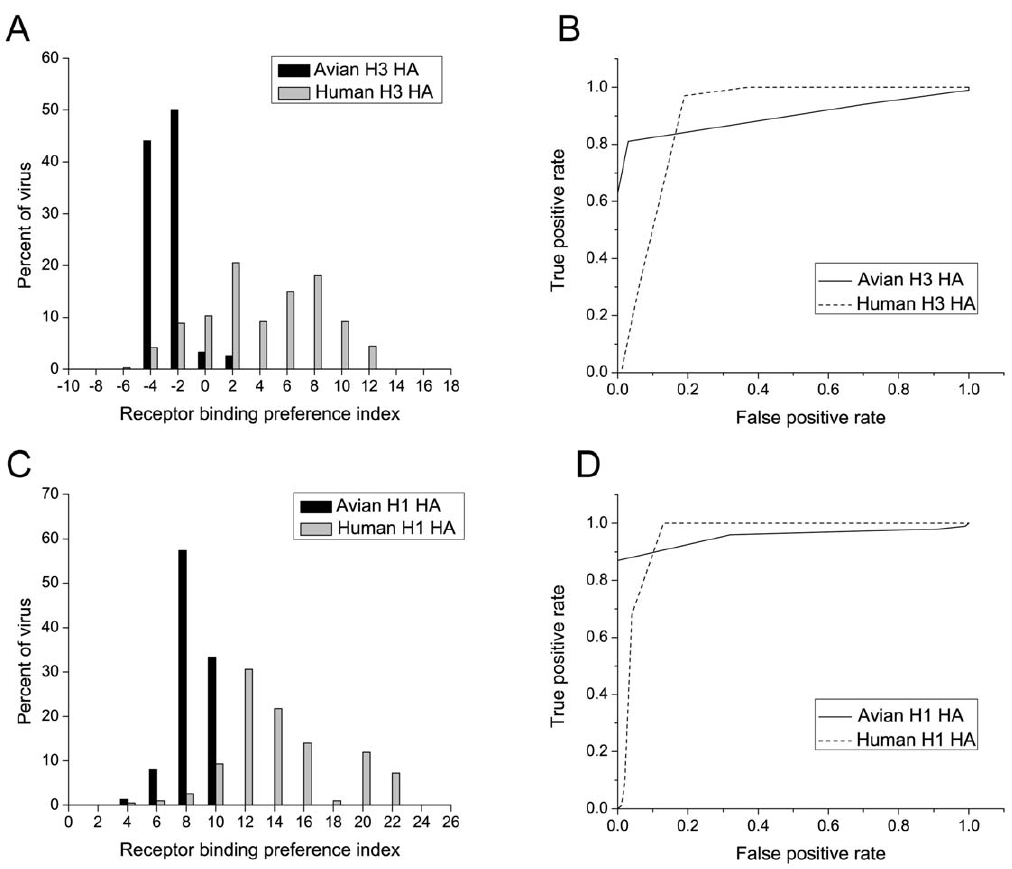
Figure 1. Predicting receptor binding preferences of natural H1, H3 and H5 viruses. A, C, The distribution of H3 (A) H1 (C) viruses isolated in humans and avian species according to their receptor binding preference indices are defined as the difference of binding score to the human and { E a 2 { 3 ). E a 2 { 3 and E a 2 { 6 indicate the predicted binding strength of HA with the avian receptor analog LSTa) and the avian receptor analogs ( E a 2 { 6 bind bind bind bind human receptor analog (LSTc), respectively. B, D, Receiver-operator characteristic (ROC) curves of predicting human/avian H3 viruses (B), human/ avian H1 viruses (D). The ROC curves are plotted as rate of true positives as a function of rate of false positives at different values of E a 2 { 6